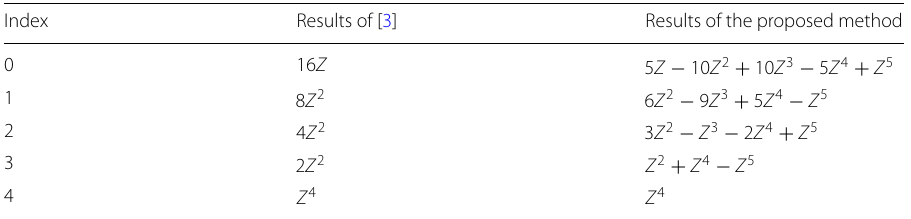
Table 1 Comparison of the upper Bhattacharyya parameter bounds of G 5 , where Z is the abbreviation of Z ( W